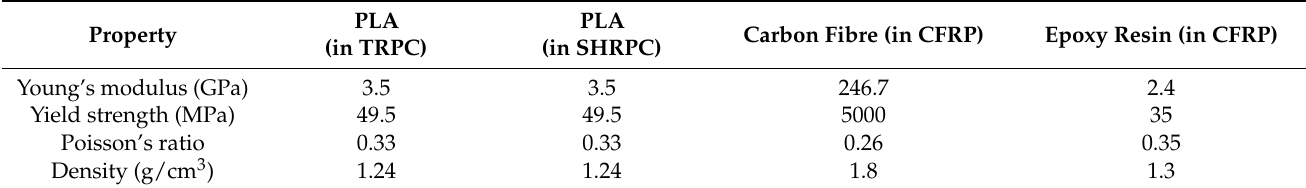
Table 1. Properties input into the TRPC, SHRPC, and CFRP models.